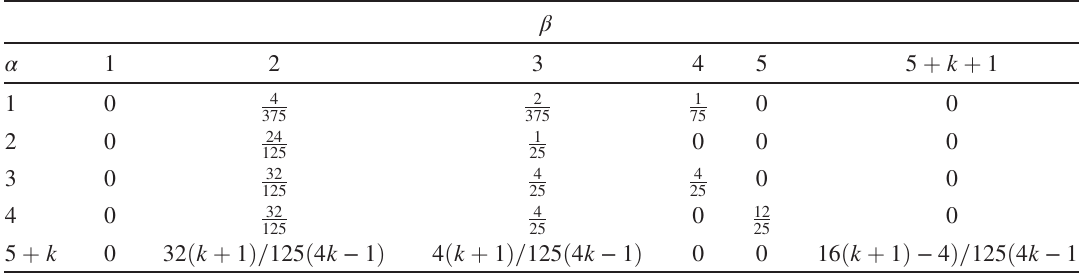
for the edge module ; β